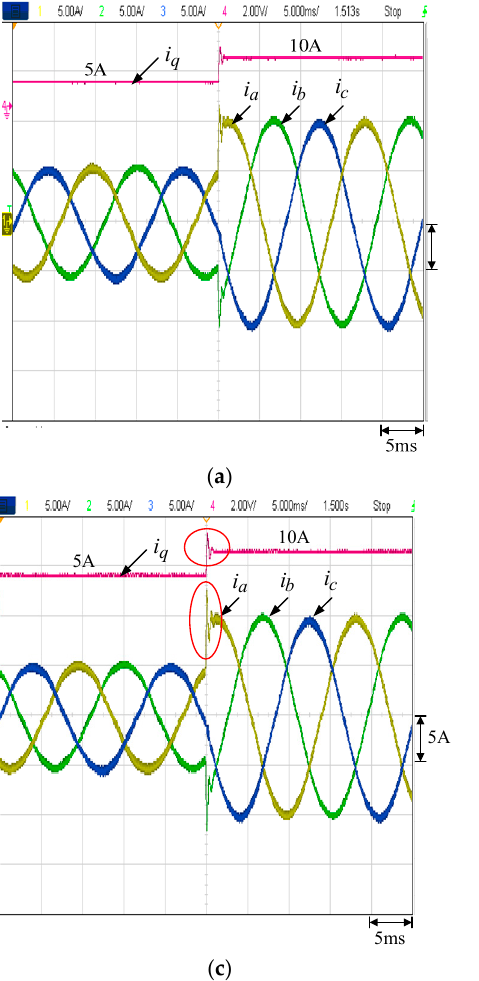
Figure 6. Winding current waveforms of the current command stepped from 5 A to 10 A at 900 rpm: ( a ) step occurs at 60° with IT2 T-S fuzzy, ( b ) step occurs at 120° with IT2 T-S fuzzy, ( c ) step occurs at 60° with IT1 T-S fuzzy and ( d ) step occurs at 120° with IT1 T-S fuzzy. Table 5. Overshoot and settling time of the IT1 and IT2 T-S fuzzy systems.